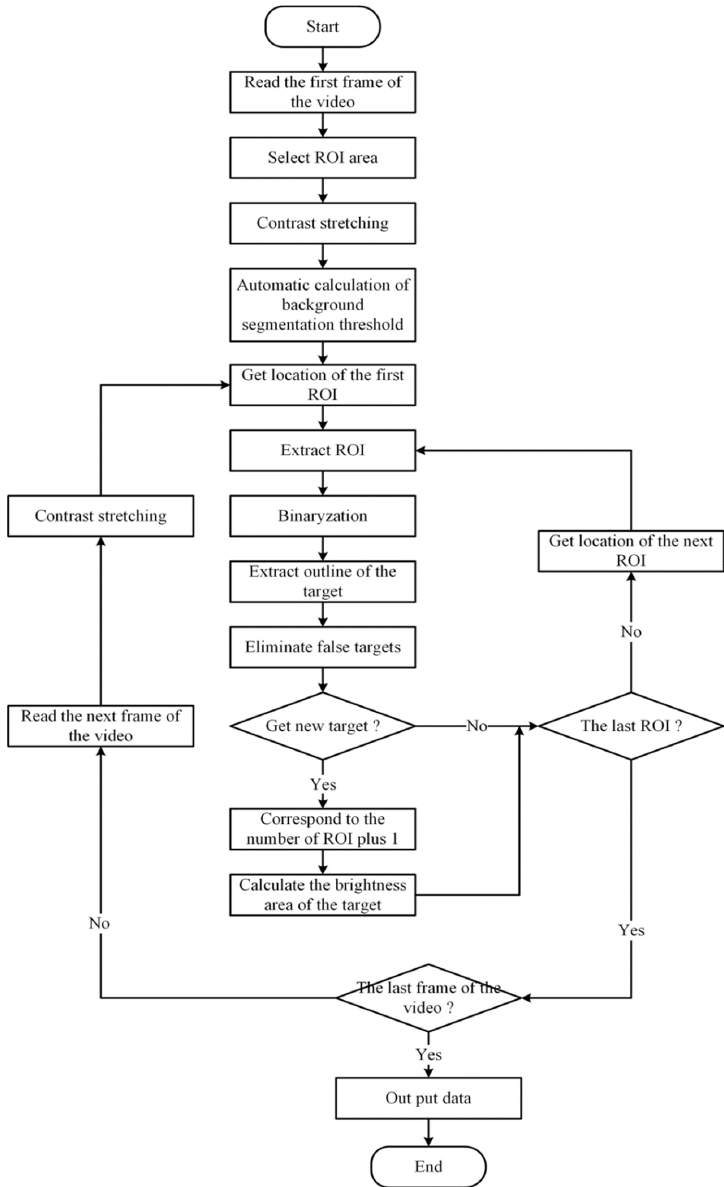
Figure 3. Flow chart of video processing by homebrew.